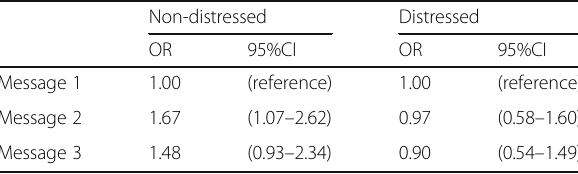
Table 4 Effects of increasing help-seeking intentions for depression among participants having no help-seeking intention before exposure to the messages